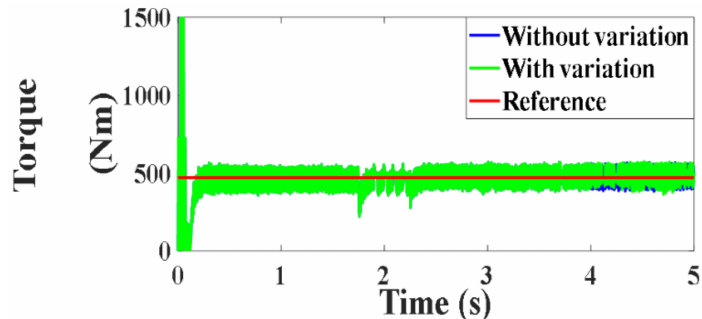
Figure 81. Developed torque under PVC